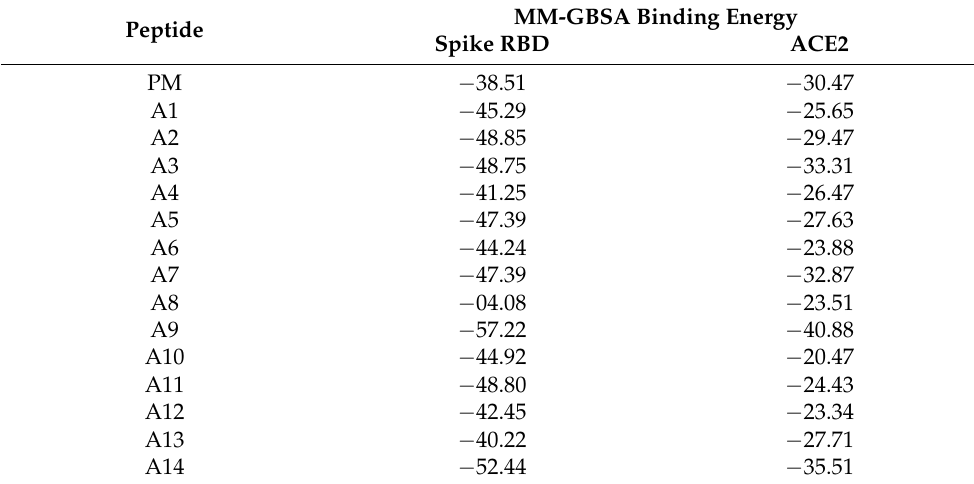
Table 1. The binding energy of the peptides with ACE2 and the RBD.